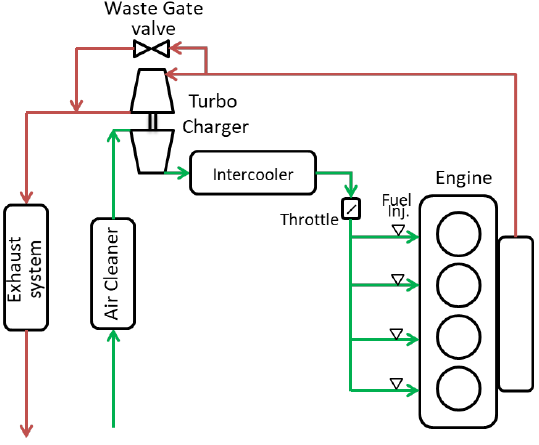
Figure 1. Schematic layout of the engine [20,27].